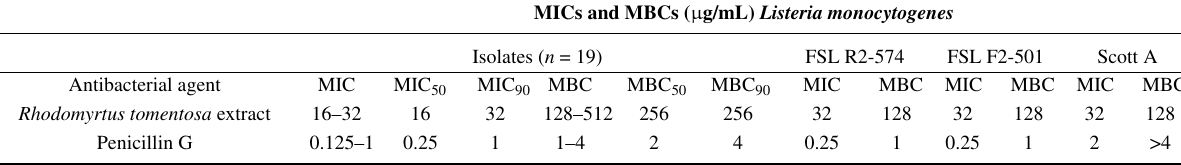
Table 3. Minimum inhibitory concentration (MIC) and minimum bactericidal concentration (MBC) of Rhodomyrtus tomentosa ethanolic leaf extract against Listeria monocytogenes isolates from ready-to-eat food and food processing plant environments. MICs and MBCs ( µ g/mL) Listeria monocytogenes Isolates ( n =